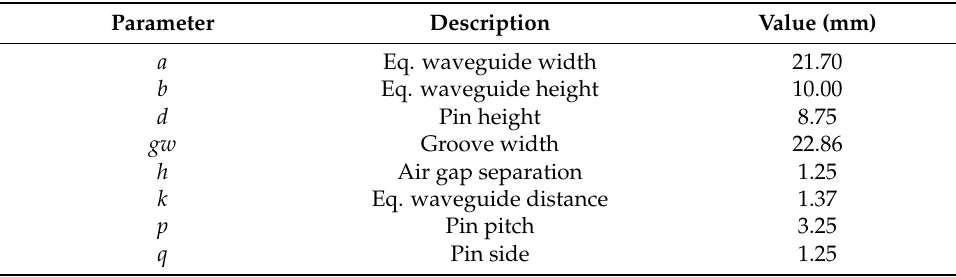
Figure 3. Groove gap waveguide scattering parameters. Table 1. Groove gap waveguide geometrical parameters.